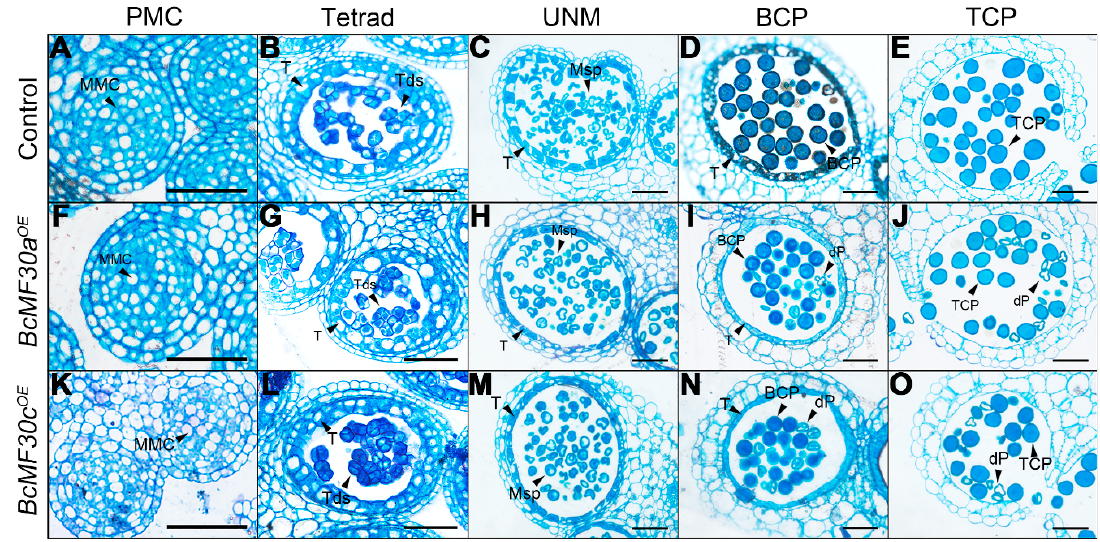
Figure 4. Semi-thin transverse sections of anthers from BcMF30a OE and BcMF30c OE plants of Brassica campestris . Semi-thin sections of anthers from the control ( A – E ), BcMF30a OE ( F – J ), and BcMF30c OE ( K – O ) plants at the pollen mother cell stage (PMC, A , F , K ), tetrad stage (Tetrad, B , G , L ), uninucleate microspore stage (UNM, C , H , M ), bicellular pollen stage (BCP, D , I , N ), and tricellular pollen stage (TCP, E , J , O ). BCP, bicellular pollen; dP, degenerated pollen; MMC, microspore mother cell; Msp, microspore; T, tapetum; TCP, tricellular pollen; Tds, tetrads. Bars = 25 μ m.